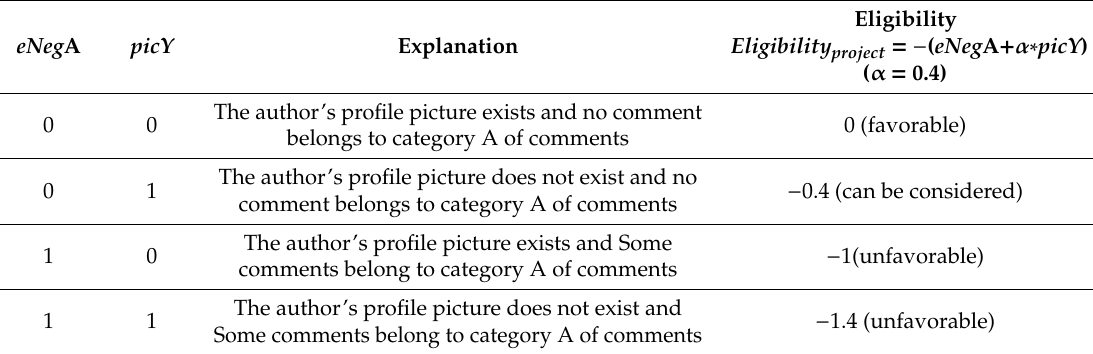
Table 5. All possible cases for a project’s eligibility